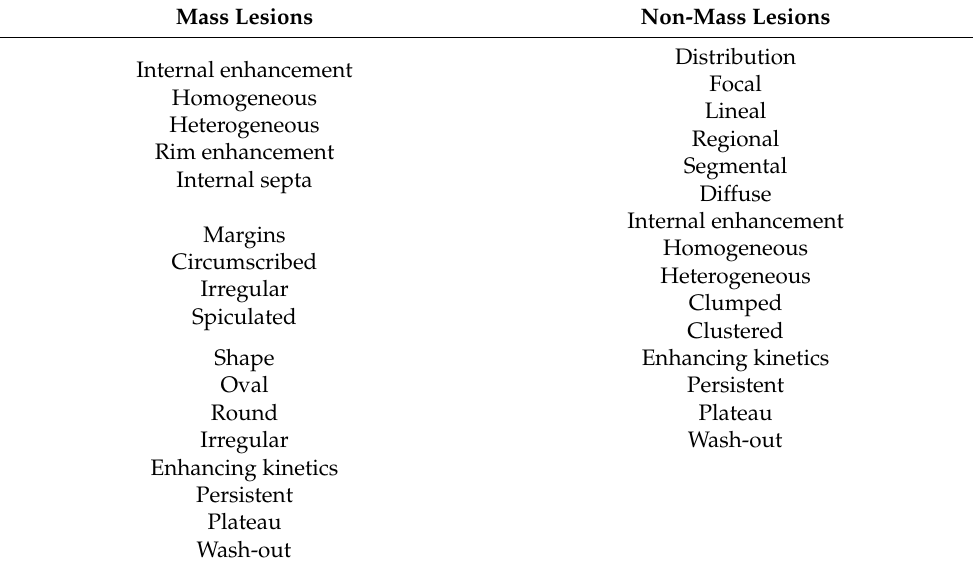
Table 1. BI-RADS descriptors for enhancing